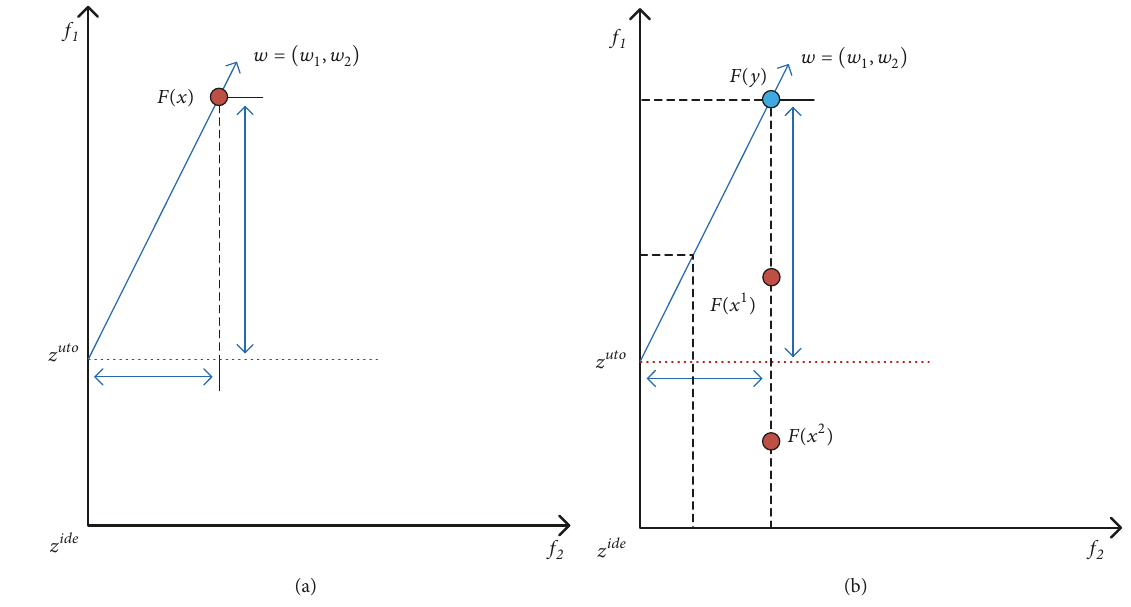
Figure 6: Tchebycheff decomposition with the utopian reference